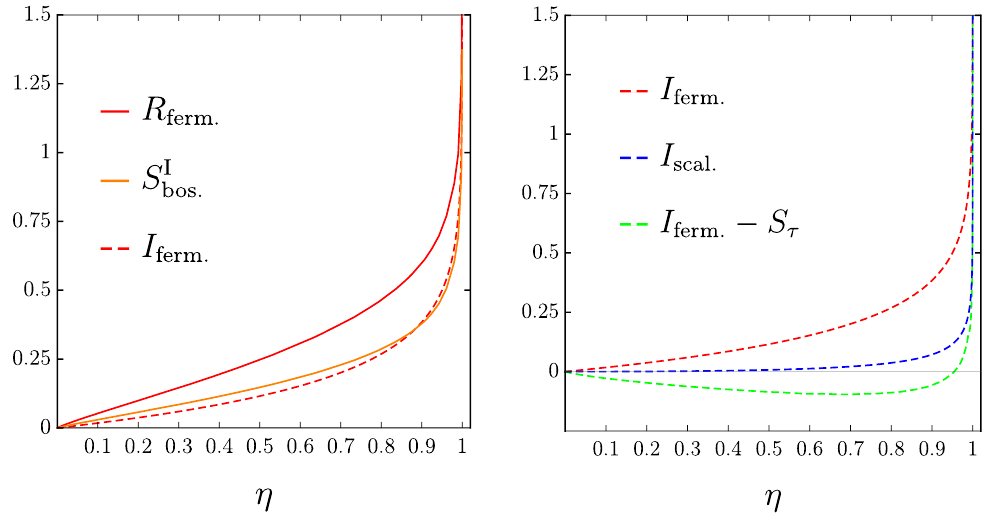
Figure 5 . (Left) We plot the re(cid:13)ected entropy for the full fermion algebra, R ferm : , the type-I entropy for the bosonic subalgebra, S I , and the mutual information for the fermion I ferm : as a bos : function of the cross-ratio (cid:17) . (Right) We plot the free-fermion and free-scalar mutual informations, I ferm : and I scal : as well as I ferm : (cid:0) S (cid:28)